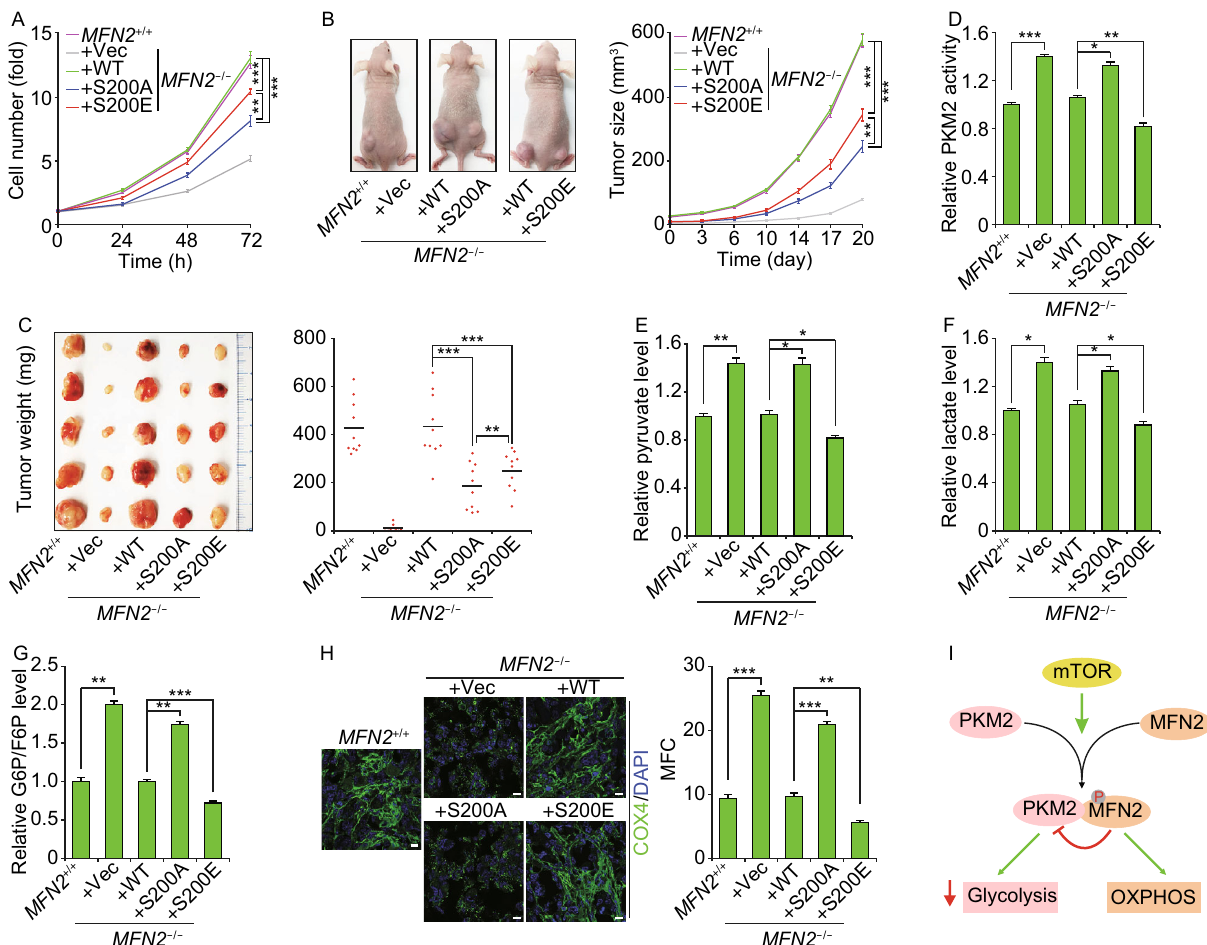
Figure 6. The phosphorylation status of MFN2 affects cancer cell growth. (A) Effect of MFN2 and its mutants on cell proliferation in H1299 cells. n = 6. (B and C) Representative images and statistical analyses showing the effect of MFN2 and its mutants on tumor size (B) or tumor weight (C) in nude mice. n = 10 mice. (D – G) Effect of MFN2 and its mutants on relative PKM2 activity (D), relative pyruvate level (E), relative lactate production (F) and relative G6P/F6P (glucose-6-phosphate/fructose-6-phosphate) level (G) in tumors from the xenograft assay. (H) Representative images and statistical analyses showing the effect of MFN2 and its mutants on mitochondrial morphology in tumors from the xenograft assay. Scale bars, 10 μ m. (I) mTOR phosphorylates MFN2 at Ser200, which enhances the interaction of MFN2 with PKM2, promotes OXPHOS by increasing mitochondrial fusion, and attenuates glycolysis. Data are shown as mean ± s.e.m. * P < 0.05, ** P < 0.01, *** P <